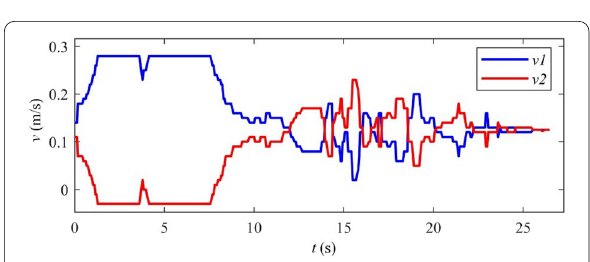
Figure 21 Velocity of two wheels in medium